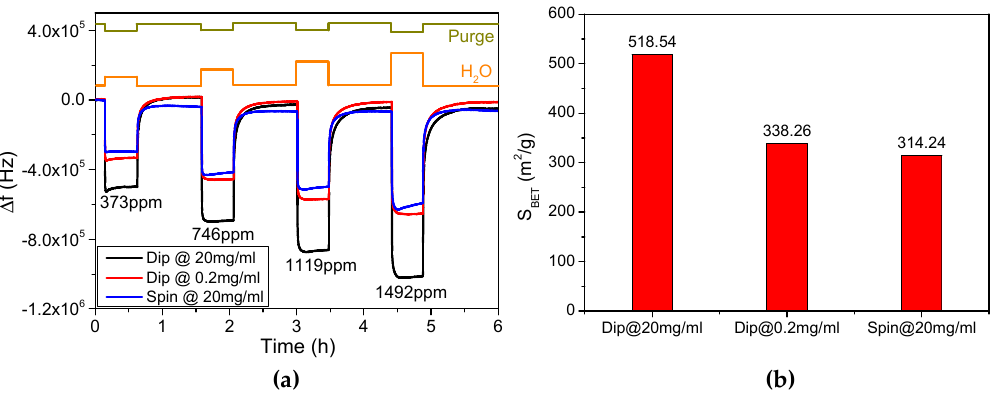
Figure 4. The morphology dependence of humidity sensing via PET-coated FBAR. ( a ) Real-time responses of FBARs with the volume concentration of water vapor changing from 373 ppm to 1492 ppm. Nano-assembled PET thin films were fabricated via dipping-assisted method in 20 mg/mL solutions (black curve), dipping-assisted method in 0.2 mg/mL solutions (red curve) and spinning-assisted method in 20 mg/mL solutions (blue curve); ( b ) specific surface area of nano-assembled PET thin films.